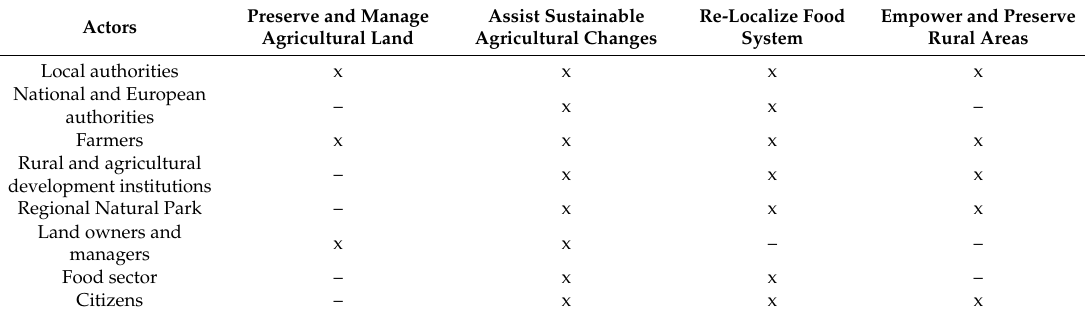
Table 3. Actors mobilized in actions proposed by the